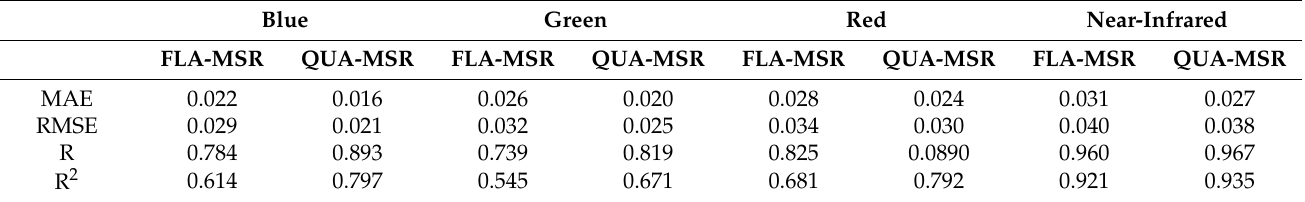
Table 5. MAE, RMSE, R, and R 2 between FLAASH/QUAAC and MSR in the blue, green, red, and near-infrared bands. The FLA-MSR is FLAASH − corrected SR and the MSR, and the QUA-MSR is QUAAC − corrected SR and the MSR.